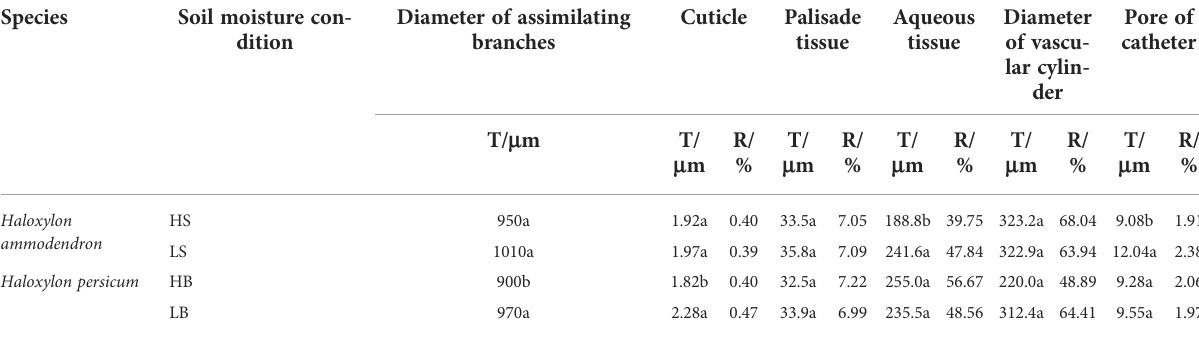
TABLE 1 Comparison of anatomical characteristics of assimilating branches of H. ammodendron and H. persicum under different soil moisture conditions. Species